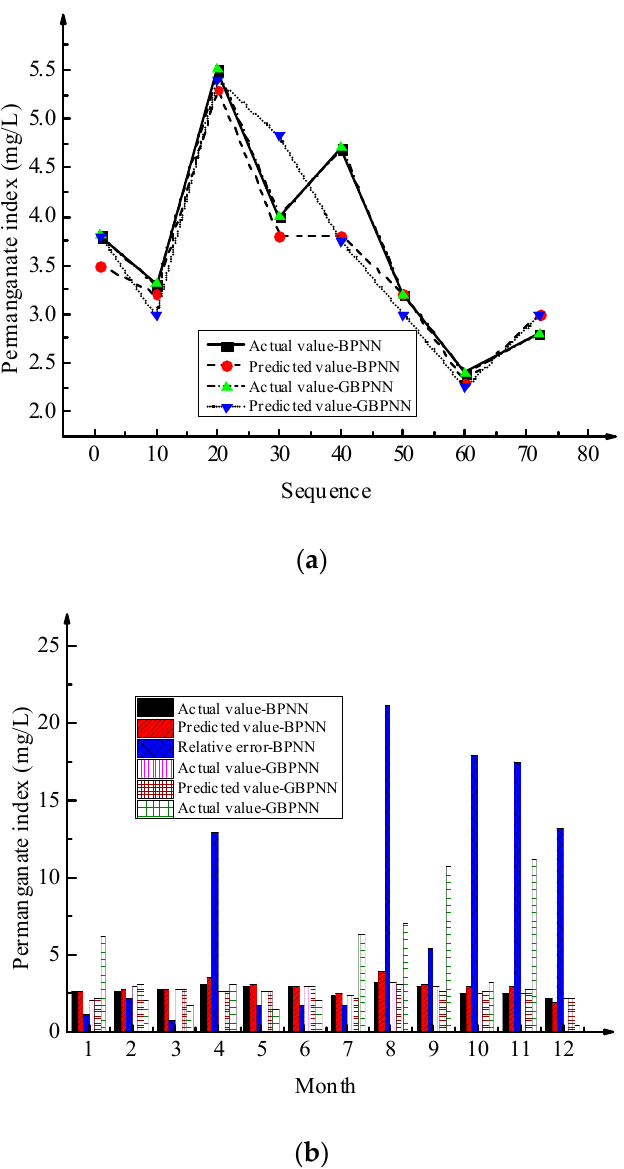
Figure 5. Comparison on data fitting and predicated value of conventional back propagation (BP) neural network (BPNN) and golden section (GBPNN) to permanganate. ( a ) data fitting; ( b ) prediction results